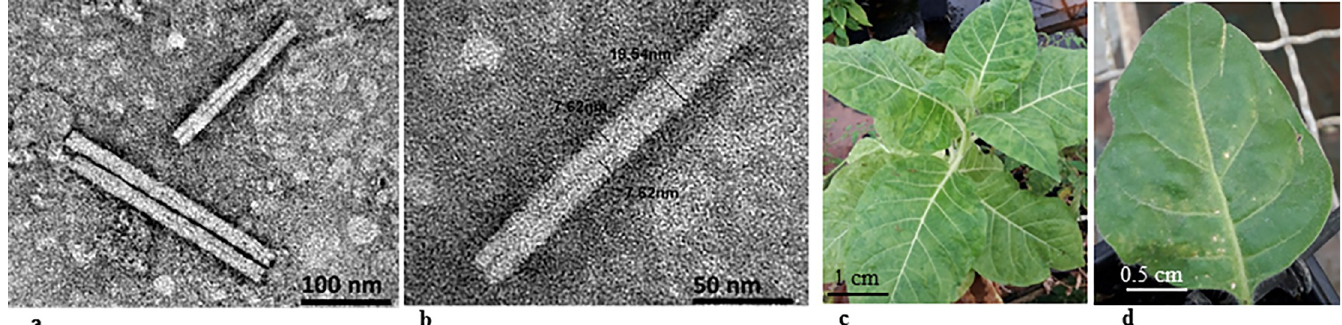
Fig 4. Electron micrograph of infectious tobamovirus particles purified from contaminated comb from bumblebee hive B. a,b. A typical tobamovirus particle morphology of S 300 nm in length and S 20 nm in width visualized by transmission electron microscopy. c. The pathogenicity of the purified virus preparation from bumblebee comb confirmed by bioassay on Nicotiana tabacum cv. Samsun showing typical mosaic and mottling symptoms. d. Bioassay of viral preparation from bumblebee comb shows necrotic local lesions on N . rustica .